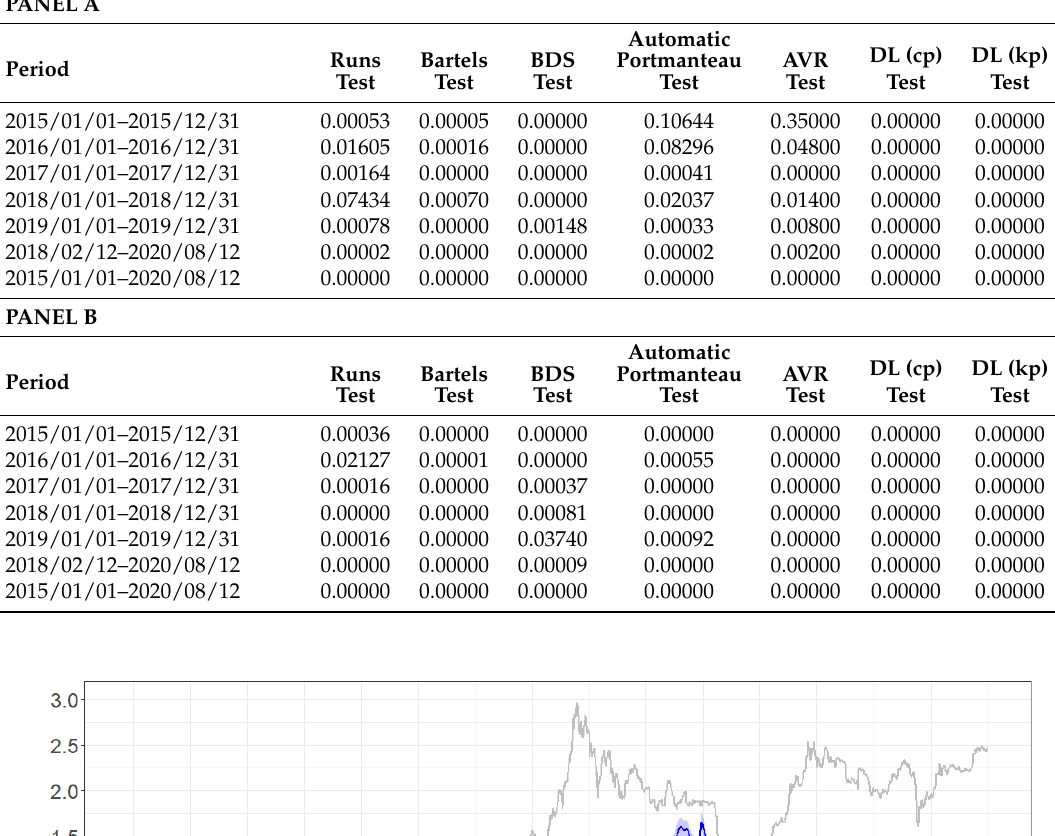
Table 2. Bitcoin market efficiency conditions. Table reports p -values for the following tests: the Runs Test (Wald and Wolfowitz 1940), the Bartels Test (Bartels 1982), the BDS Test (Broock et al. 1996), the Automatic Portmanteau Test (Escanciano and Lobato 2009), the AVR Test (Choi 1999; Kim 2009; Lo and MacKinlay 1988), and the DL Test (Domínguez and Lobato 2003). For BDS the table reports the average p -values across specifications with embedding dimensions from 2 to 5; for the AVR test we compute 500 bootstrap iterations; for DL the table reports both the wild-bootstrap p -values of the Cramer von Mises test statistic (cp) and of the Kolmogorov-Smirnov test statistic (kp). Panel A refers to Bitcoin returns, while Panel B reports the results for the corresponding volatility computed as the